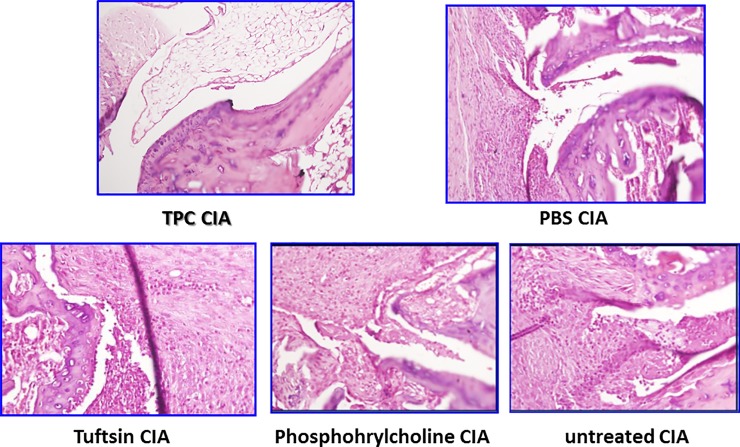
Histological analysis.Representative arthritic paws from each study group of CIA mice were removed and stained with H&E. Magnification presented × 100.